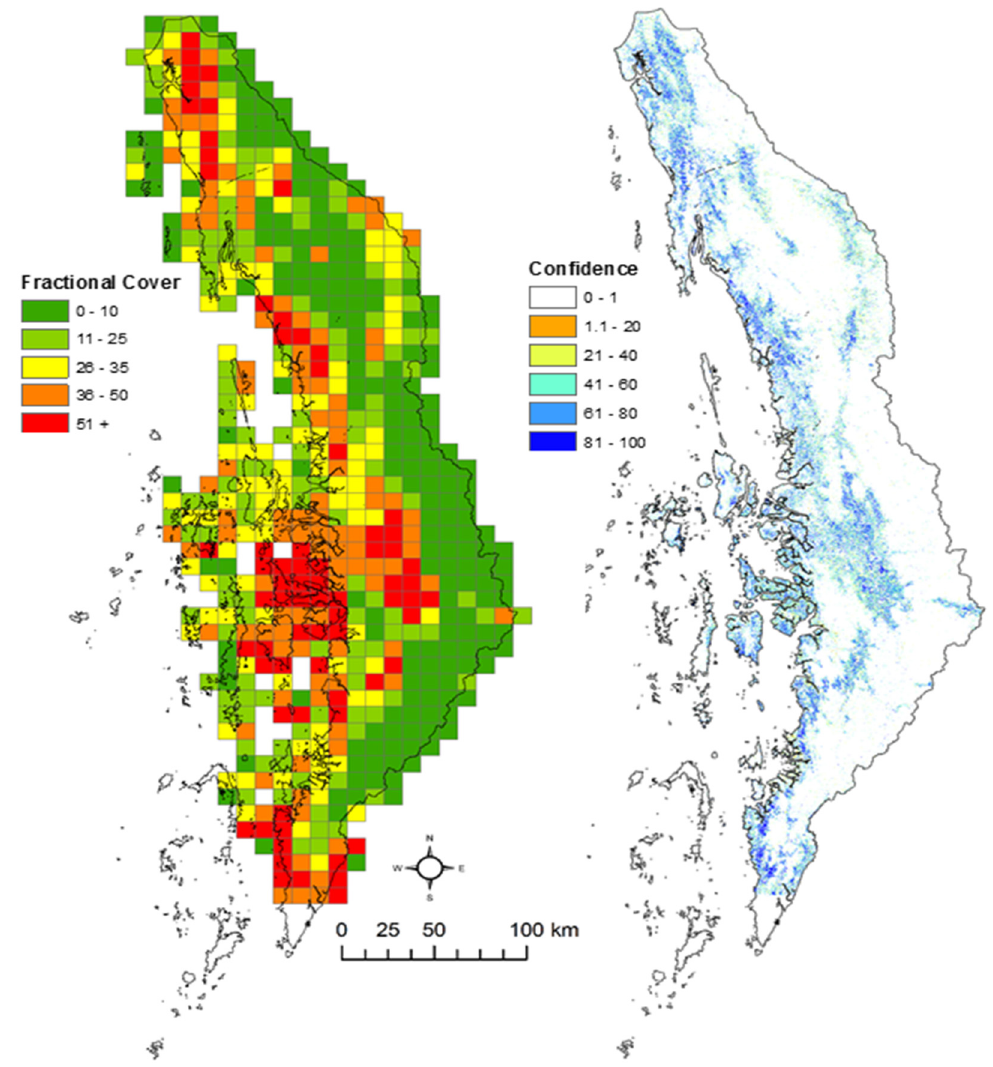
Figure 10. Plantation fractional cover and confidence maps for Tanintharyi, Myanmar.